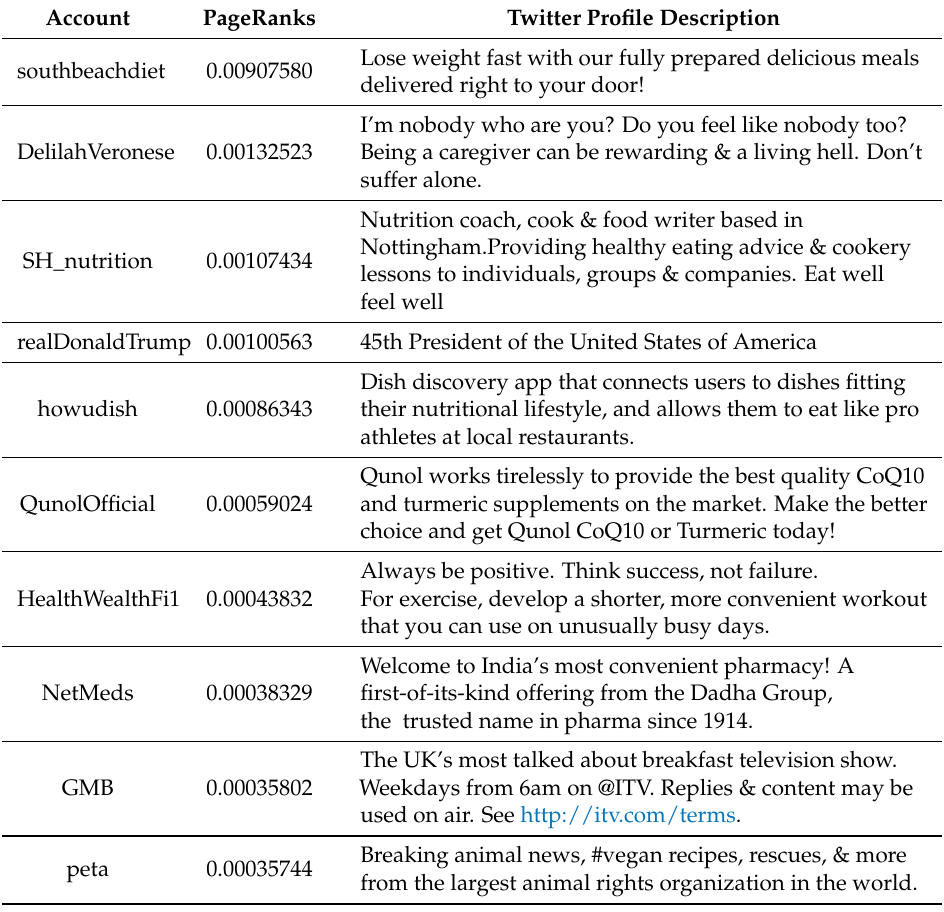
Table 5. The 10 Most Influential Users in the Health Diet